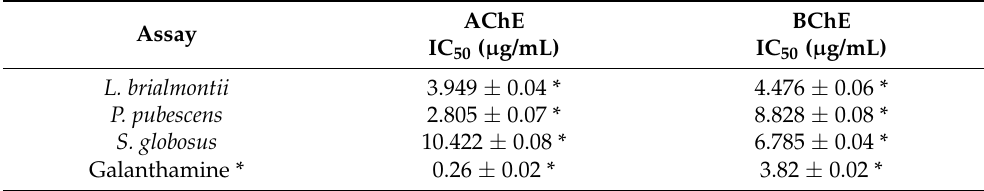
Table 5. Enzyme inhibitory activity of Lecania brialmontii , Pseudephebe pubescens and Sphaerophorus globosus . AChE Assay IC 50 ( µ g/mL)